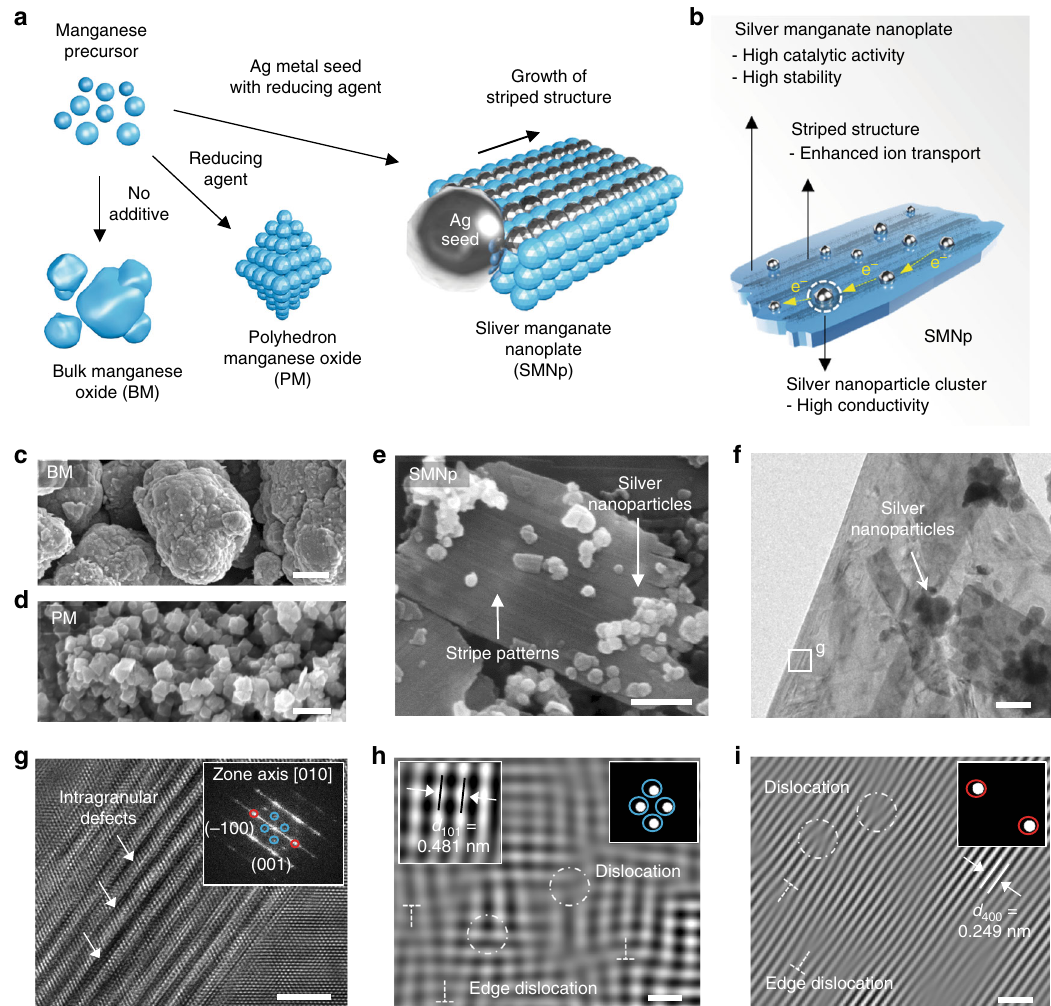
Fig. 1 Formation of the stripe pattern and dislocation. a , b Schematic of the synthesis process ( a ) of the bulk manganese oxides (BM), polyhedron manganese oxide (PM), and silver manganate nanoplate (SMNp), and the summary of the catalytic effects ( b ) of the SMNp. c – e Scanning electronic microscopy (SEM) images of the BM ( c ), PM ( d ), and SMNp ( e ) showing plate-like structures with silver nanoparticles. f , g High-resolution transmission electron microscopy (HR-TEM) images of the SMNp ( f ) and high-magni fi ed image ( g ) of the box in f , which shows zigzag atomic arrangements with intragranular cracking. Fast Fourier transform (FFT) image of g presents the lattice planes of ( – 100) and (001) along the [010] zone, indicating the orthorhombic structure of Ag 2 MnO 4 . h , i Inverse FFT images of applied masks at the blue circle ( h ) and red circle ( i ) in g , showing a wide range of dislocations with defects. The dislocations are shown by circles and edge dislocations are represented by a T-shaped symbol. The upper right insets in h and i indicate the applied masks and the lattice spacing of the (101) plane is denoted as the left inset in h . Scale bars, 5 μ m ( c ), 500 nm ( d ), 200 nm ( e ), 100 nm ( f ), 4 nm ( g ), and 1 nm ( h , i